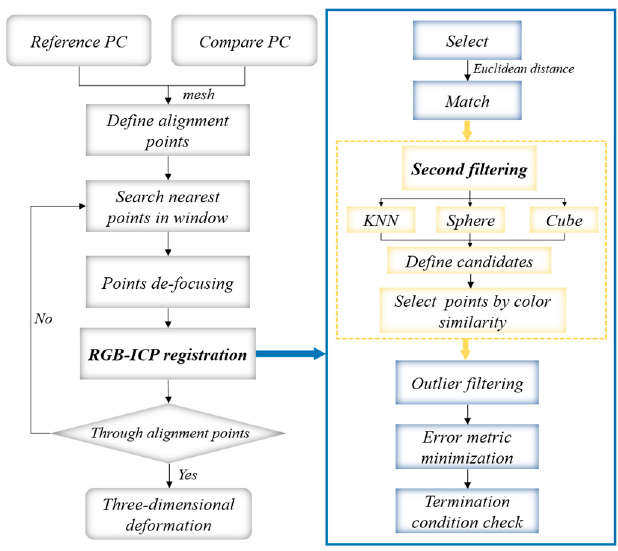
Figure 2. Flowchart of traditional ICP method with fused RGB.